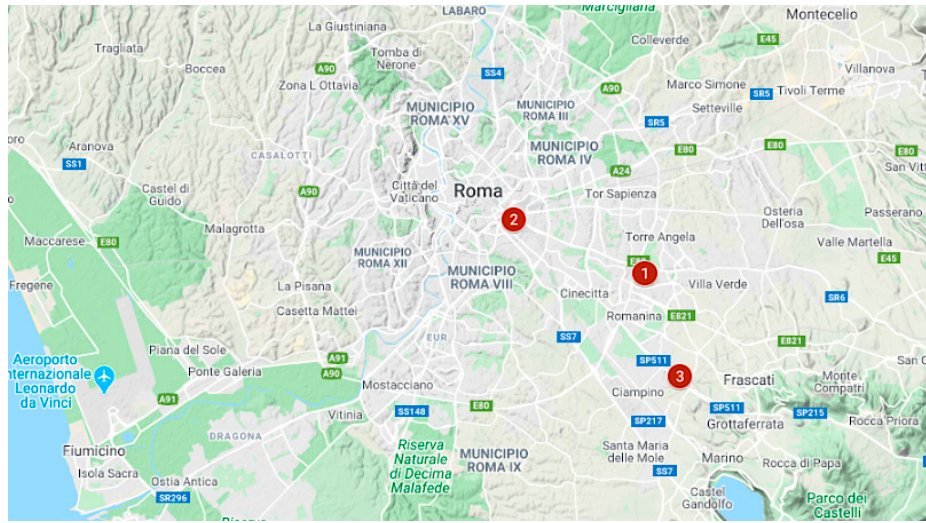
Figure 3. Location of the three properties considered. Table 7. Main data.